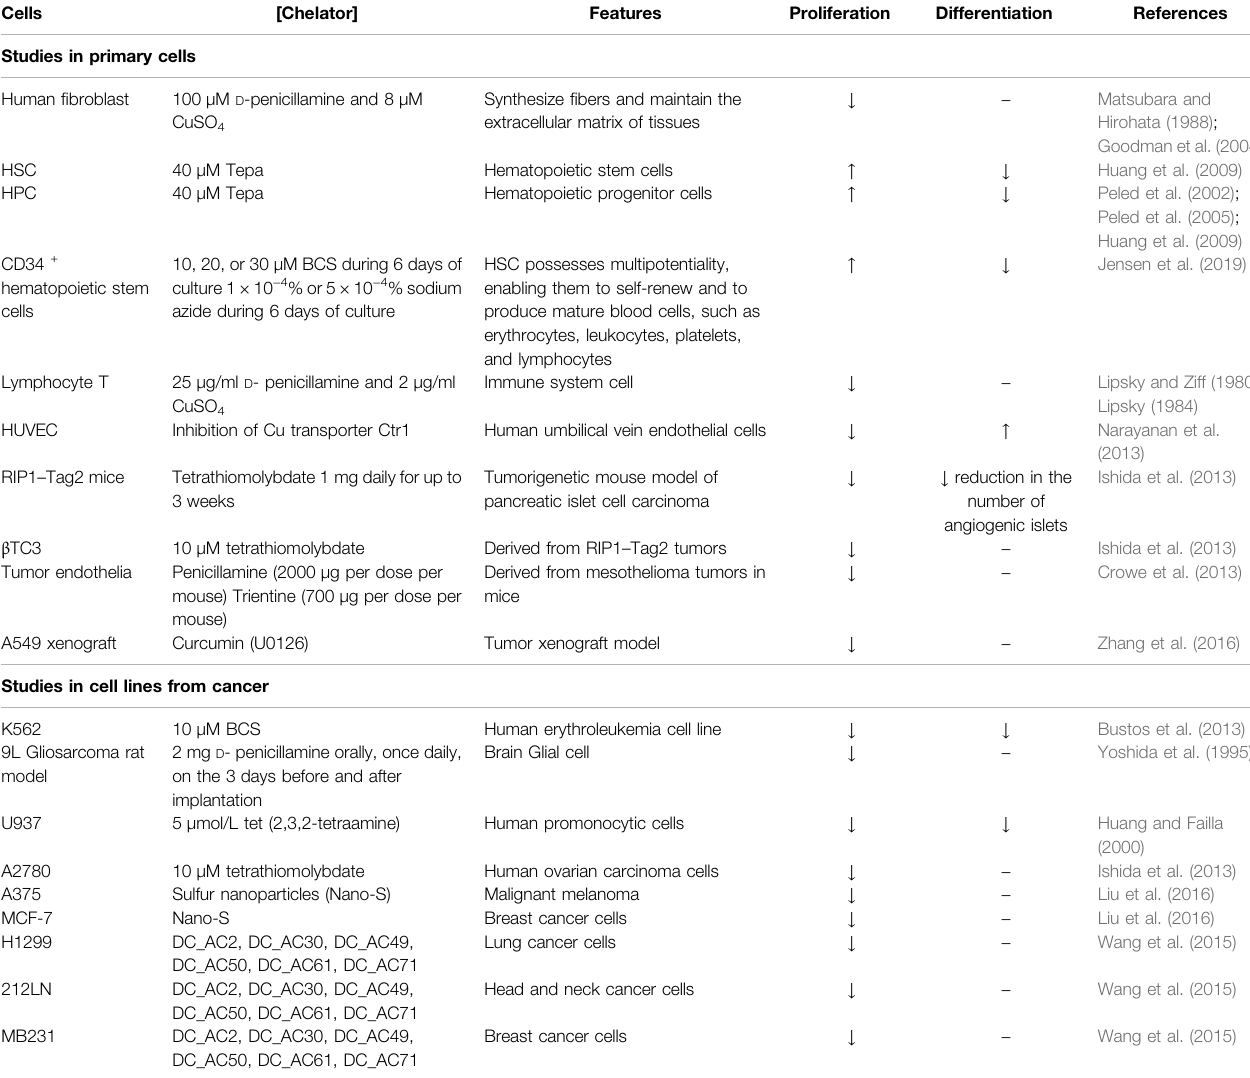
TABLE 3 | Effect of copper decline on proliferation and differentiation in different cell